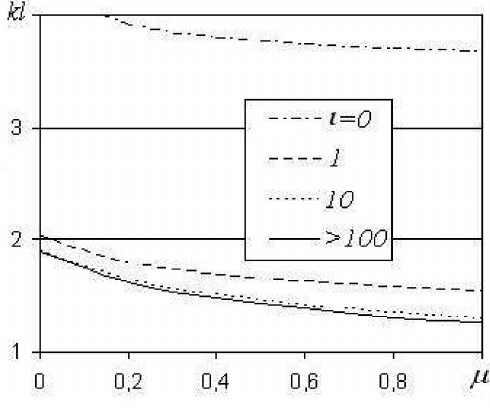
Fig. 3. Main eigenvalue of a bow and stabilizer modeled as a cantilever-rod